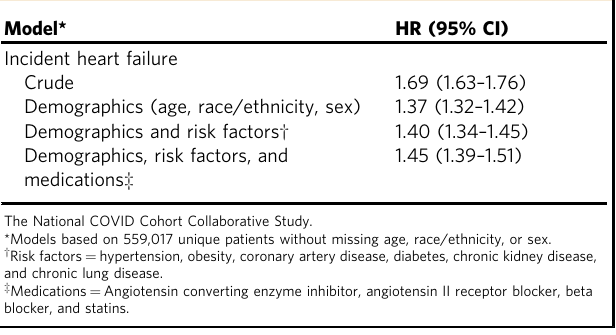
Table 4 Multivariable Cox regression models analyzing hazard ratios of post-discharge incident heart failure among patients with and without COVID-19